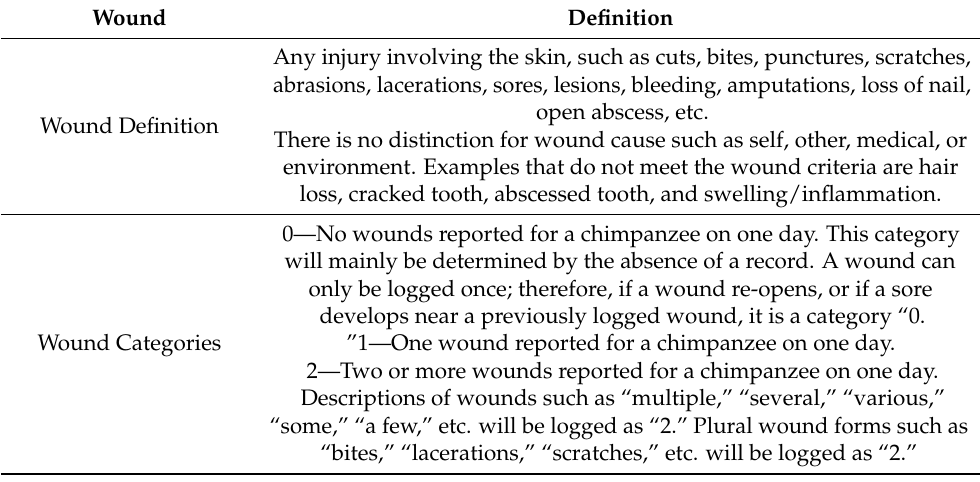
Table 3. Wound Definition and